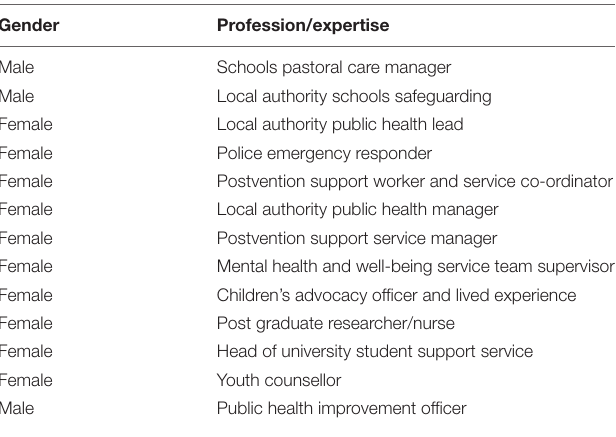
TABLE 1 | Workshop attendees by professional expertise and